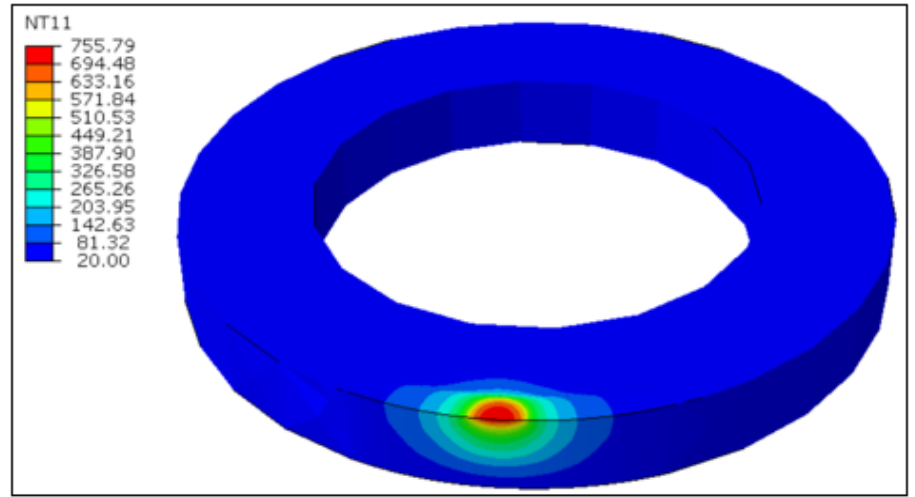
Figure 14. Steady-state tool surface temperature at V = 100 m/min for the fixed tool (°C).